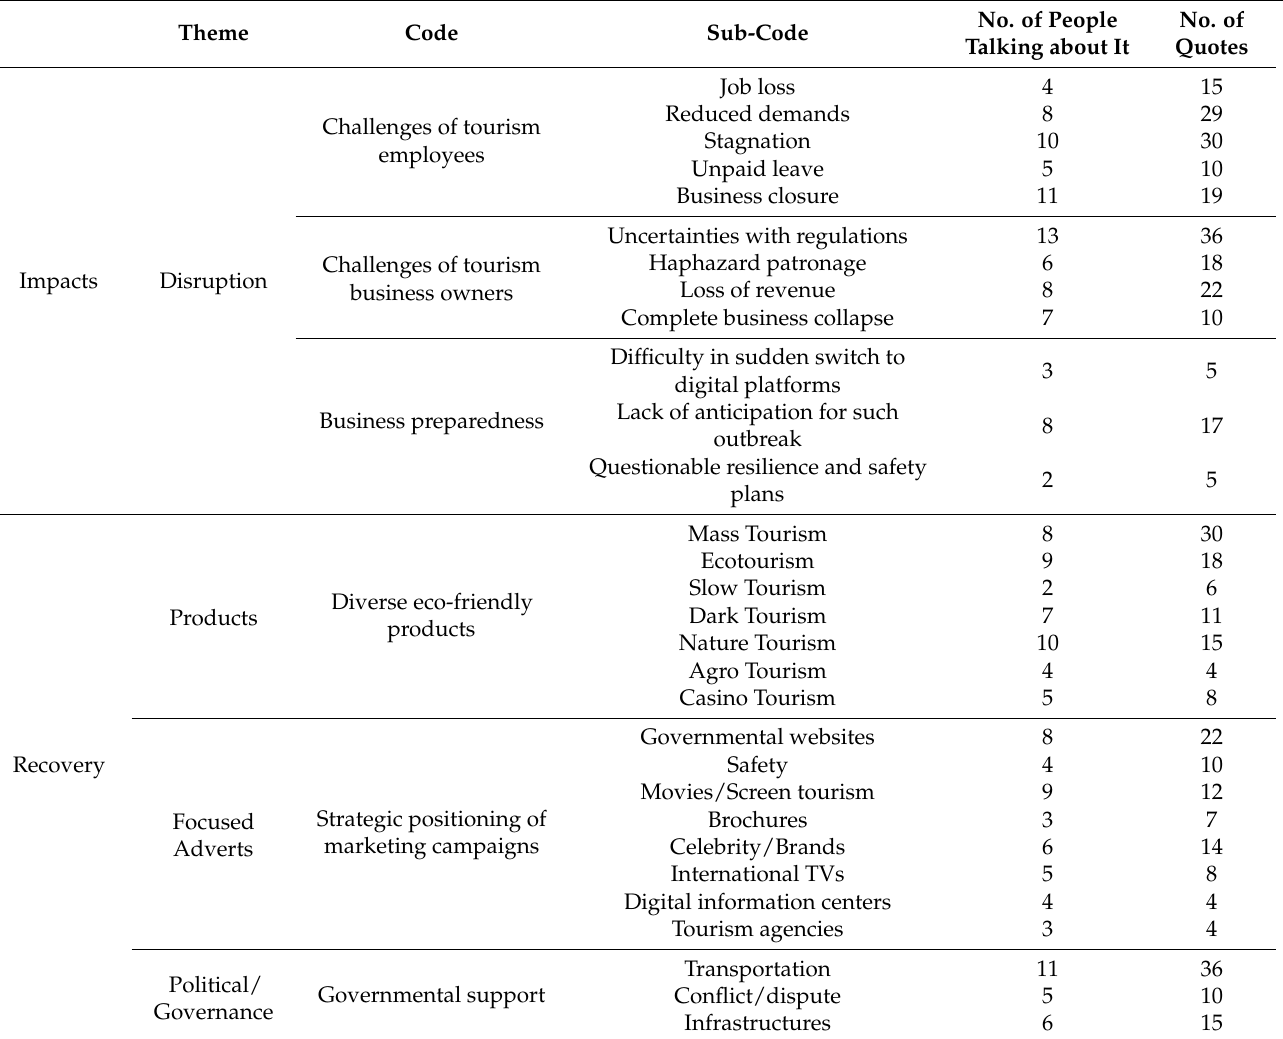
Table 2. Themes and coding structures indicating the significance of each